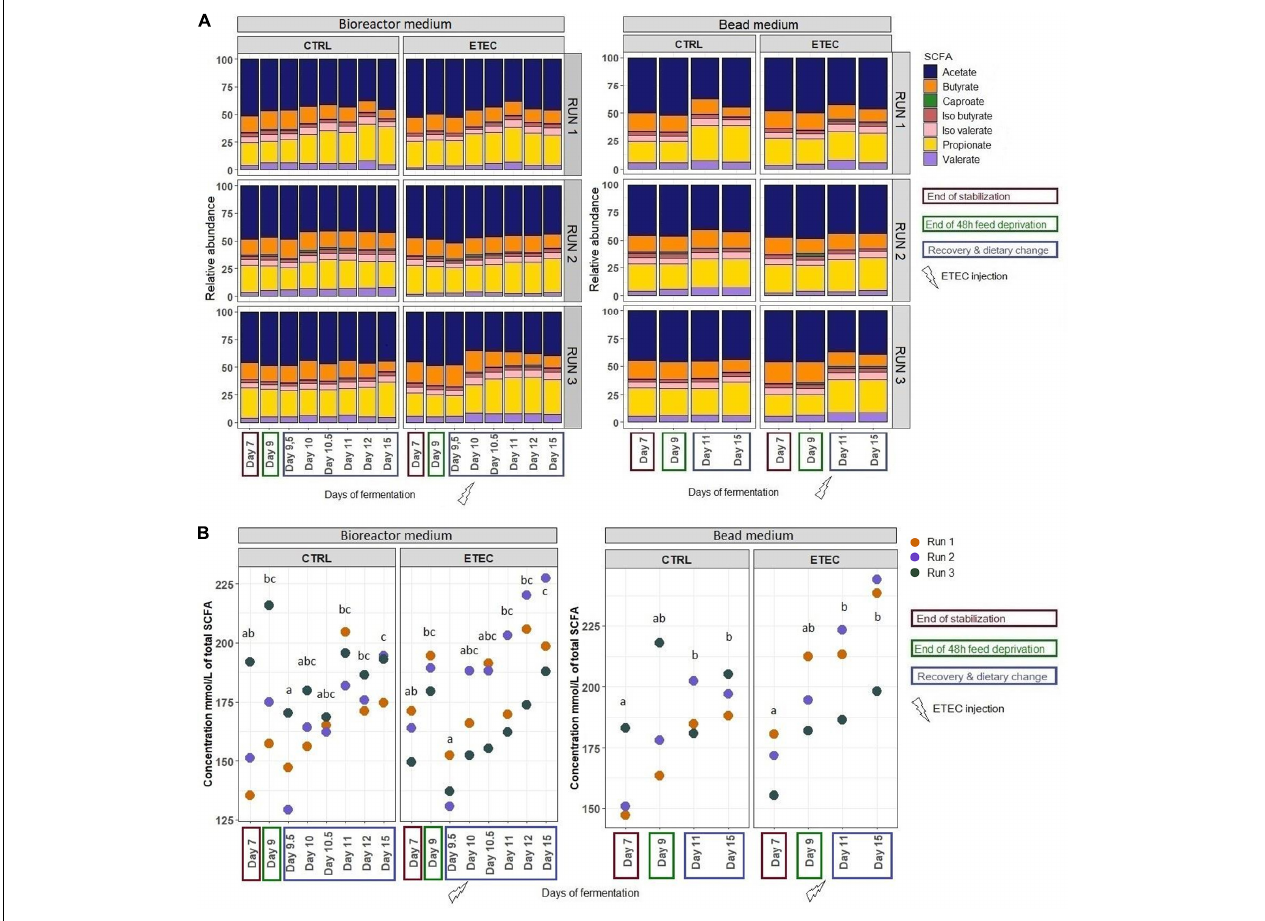
FIGURE 2 | Short chain fatty acids (SCFA) relative abundances (A) and Evolution of the total concentration of SCFAs (B) produced by fermentation activity of the microbiota inhabiting the MPigut-IVM in the CTRL and ETEC conditions for the runs #1, 2, and 3. Groups (days) associated with different letters are significantly different ( P <